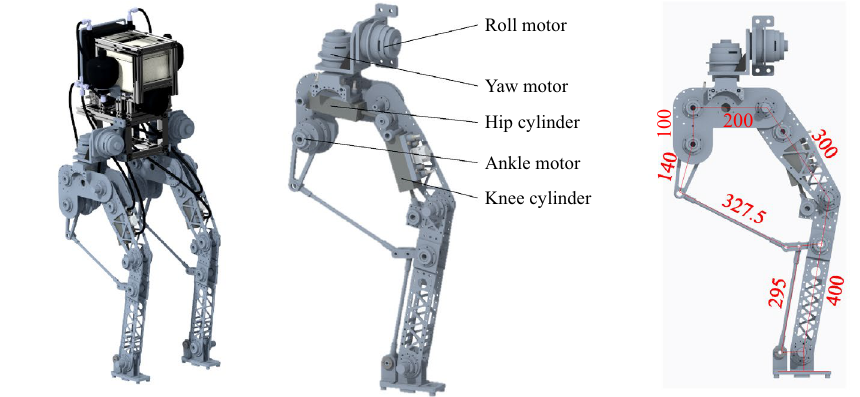
Figure 1. Mechanical structure of hybrid drive